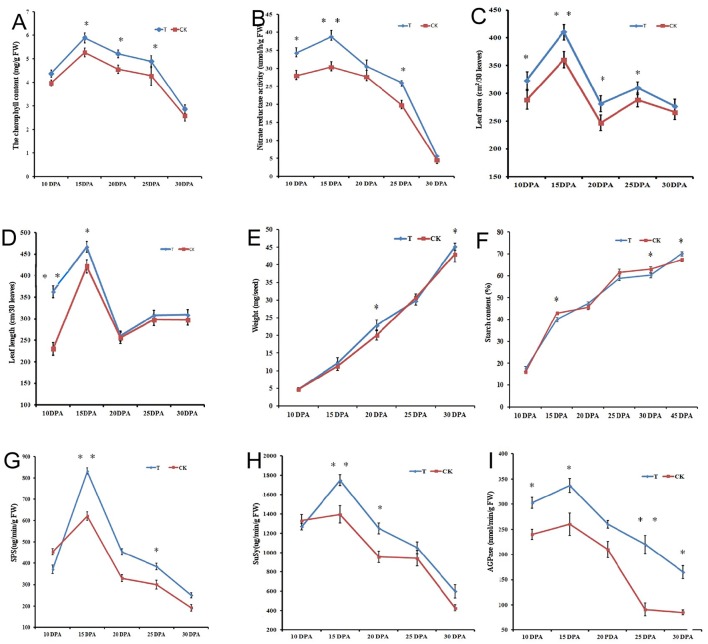
Physiological and biochemical changes of flag leaves (A–D) and grains (E–I) from Chinese elite bread wheat cultivar Zhongmai 175 under high N and normal N fertilizer conditions. (A) Total chlorophyll content. (B) Nitrate reducase activity. (C) Leaf area. (D) Leaf length. (E) Grain weight. (F) Total starch content. (G) SPS activity. (H) SuSy activity. (I) AGPase activity. Error bars indicate standard errors of three biological replicates. Statistically significant differences between treatments and the control were calculated by independent Student's T-tests: *p < 0.05; **
p < 0.01. T and CK indicate the high-N treated group and control group, respectively.